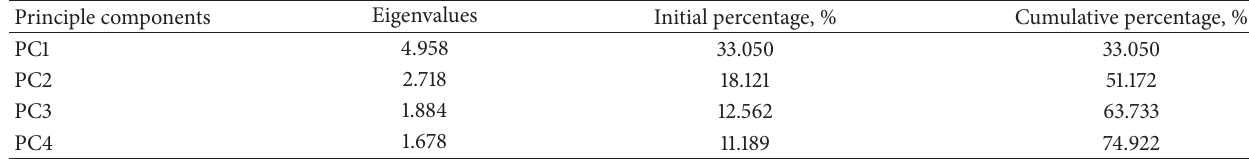
Table 7: Eigenvalues and cumulative percentage of first five principal components.